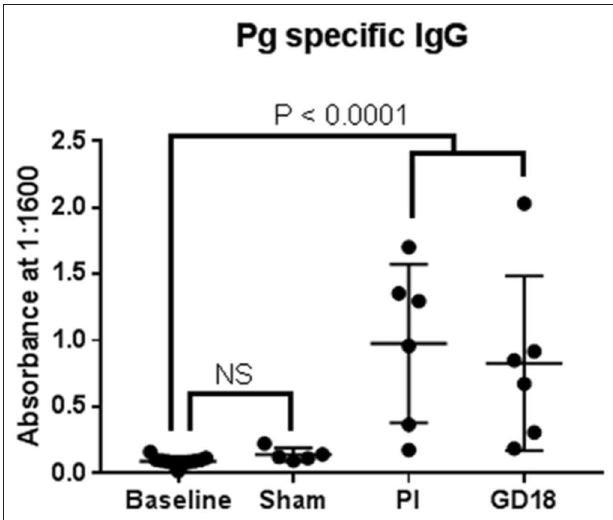
FIGURE 2 | We also measured P. gingivalis specific IgM and IgG before (baseline), after inoculation, and during pregnancy to assess microbial